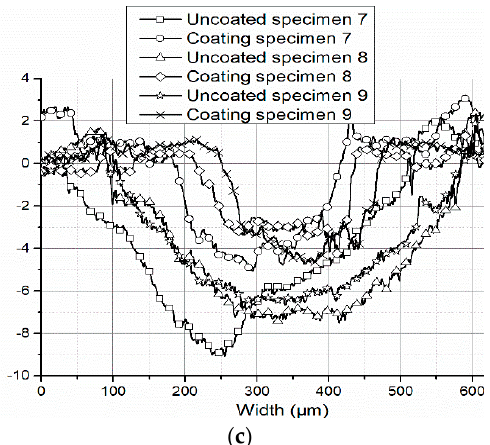
Figure 6. Curve diagram of the wear section of specimens: ( a ) Nos. 1–3 specimens; ( b ) Nos. 4–6 specimens; ( c ) Nos. 7–9 specimens.